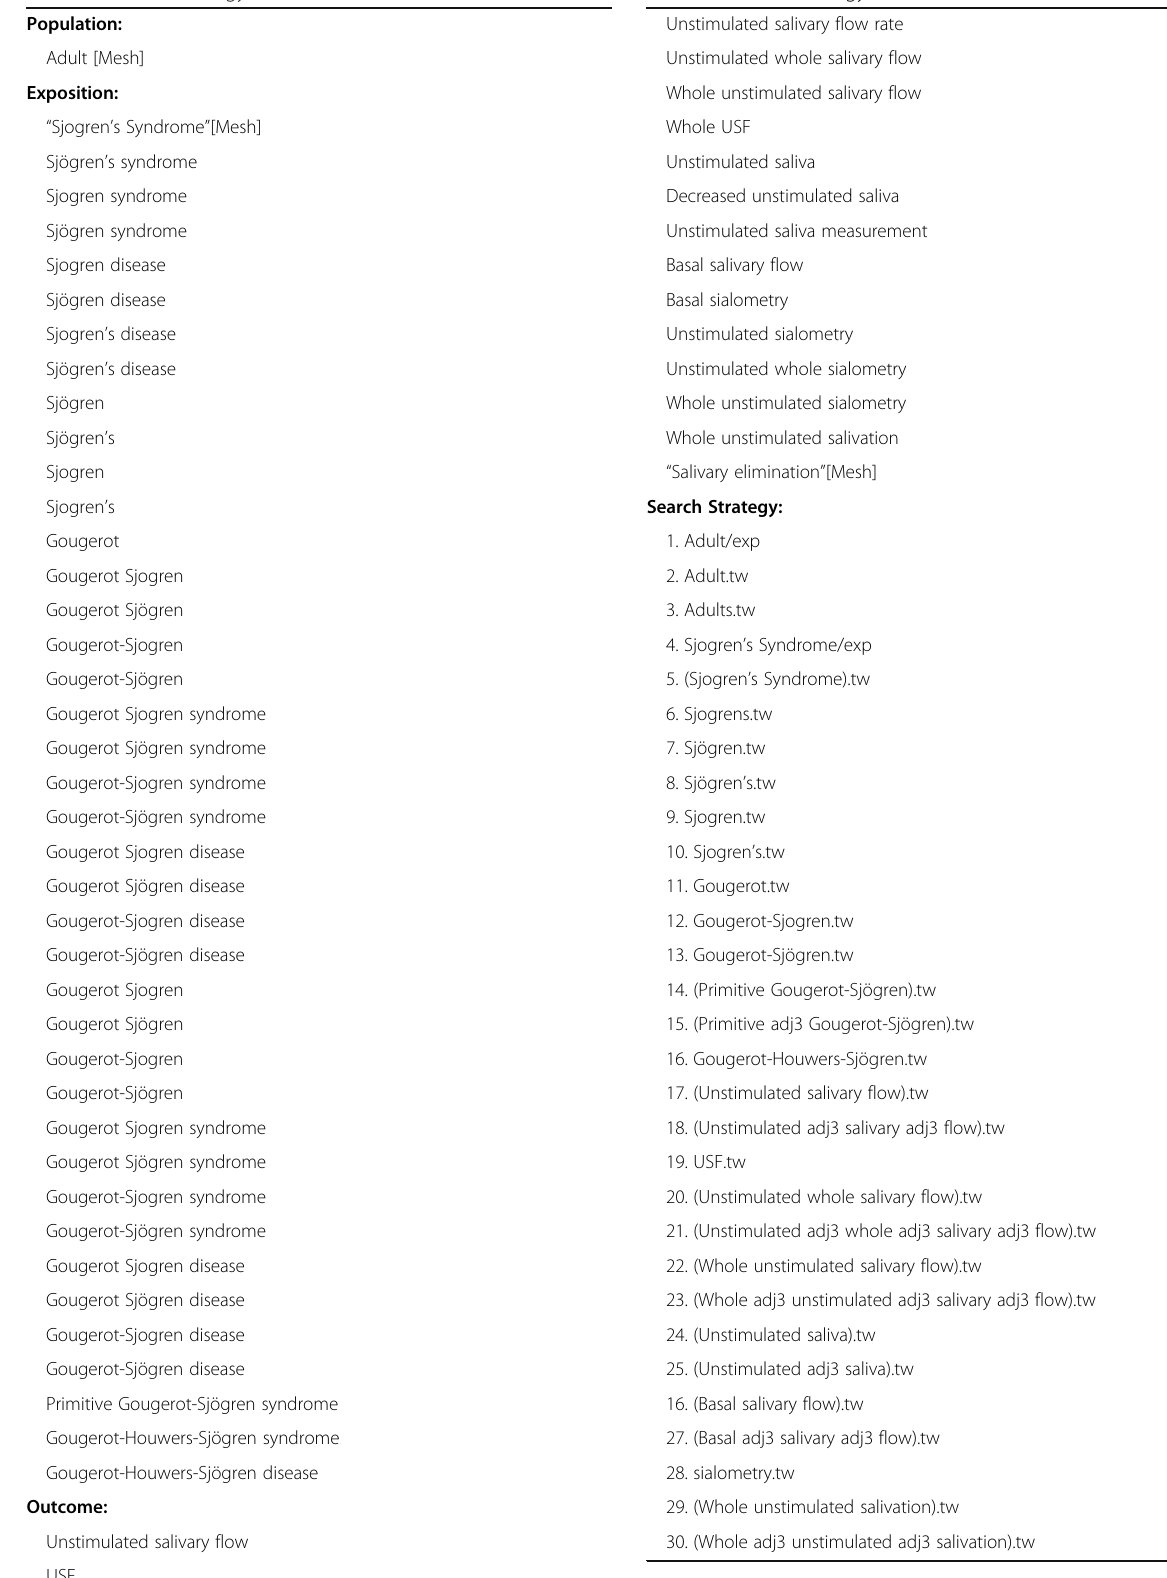
Table 1 Search Strategy